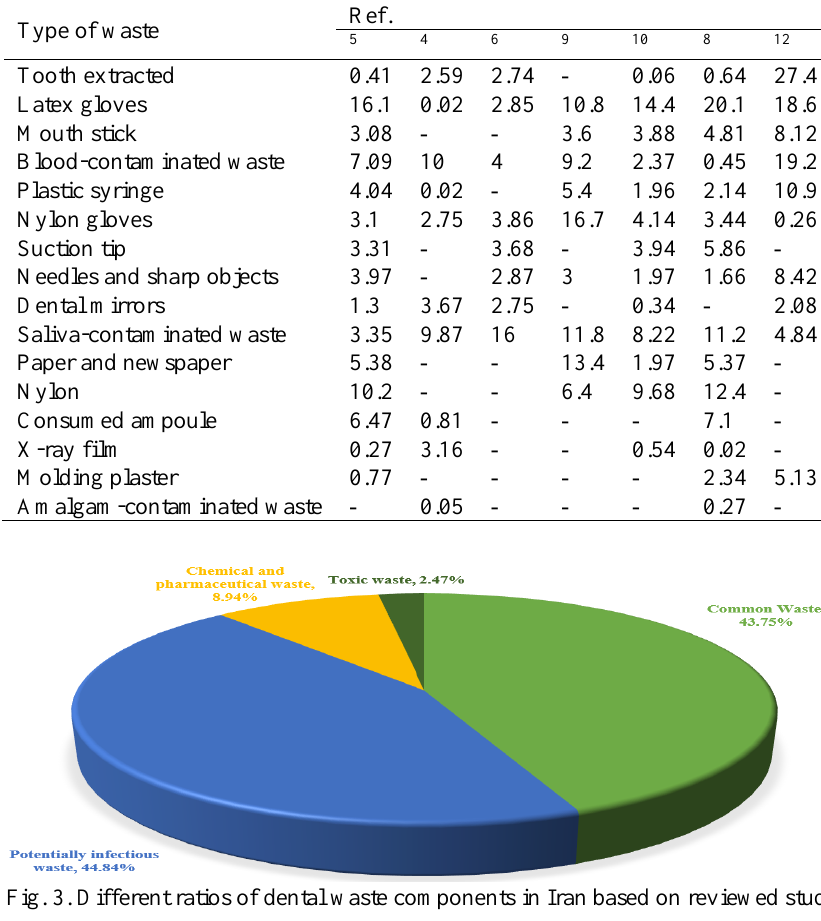
Table 4. Ratio of some components of dental wastes in Iran (%)